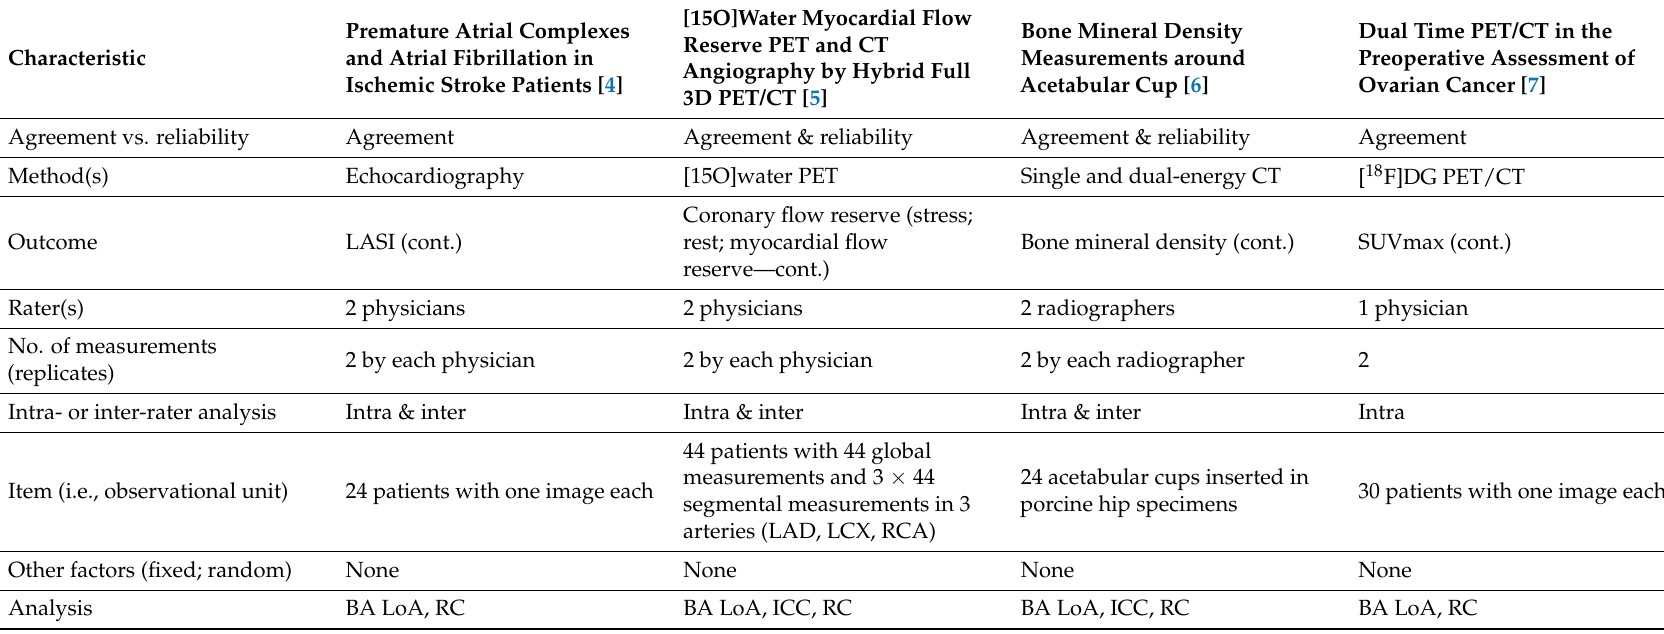
Table 1. Main characteristics template for an agreement and/or reliability